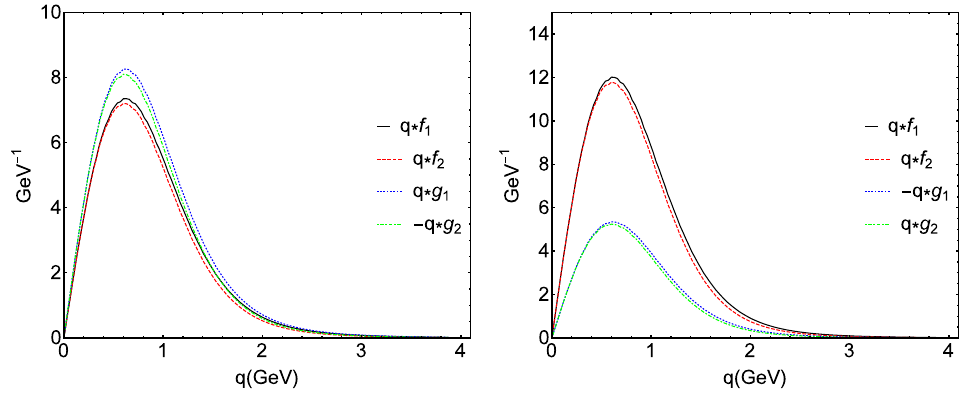
Figure 6 . The 1 + wave functions of the 1 1 P 1 − 1 3 P 1 mixing states B c 1 (1 P ) (left) and B 0 (right). f 1 and f 2 terms are 1 P 1 waves; g 1 and g 2 terms are 3 P 1 waves.